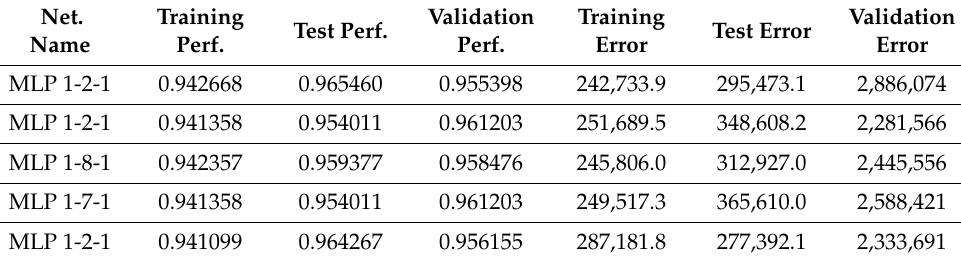
Table 6. Alternative univariate models for forecasting the gross value added of Y manuf. . Net.